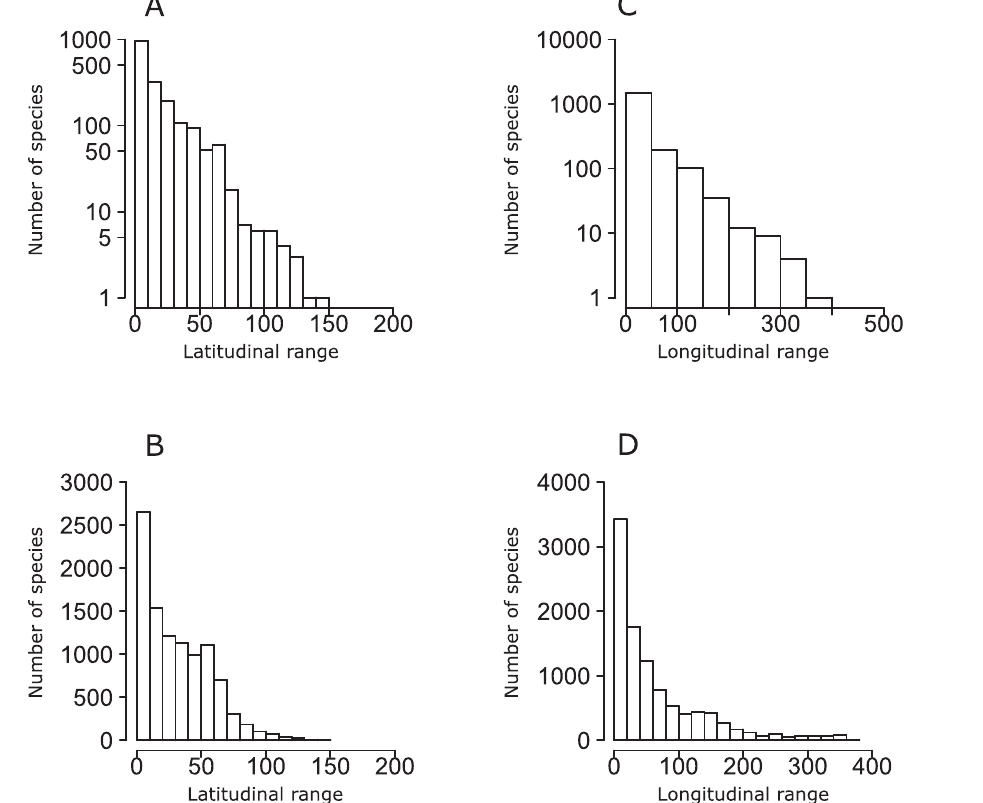
Figure 3. Frequency distribution plots of both maximum latitudinal (A and B) and longitudinal (C and D) ranges for freshwater (A and C) and marine (B and D) fishes.